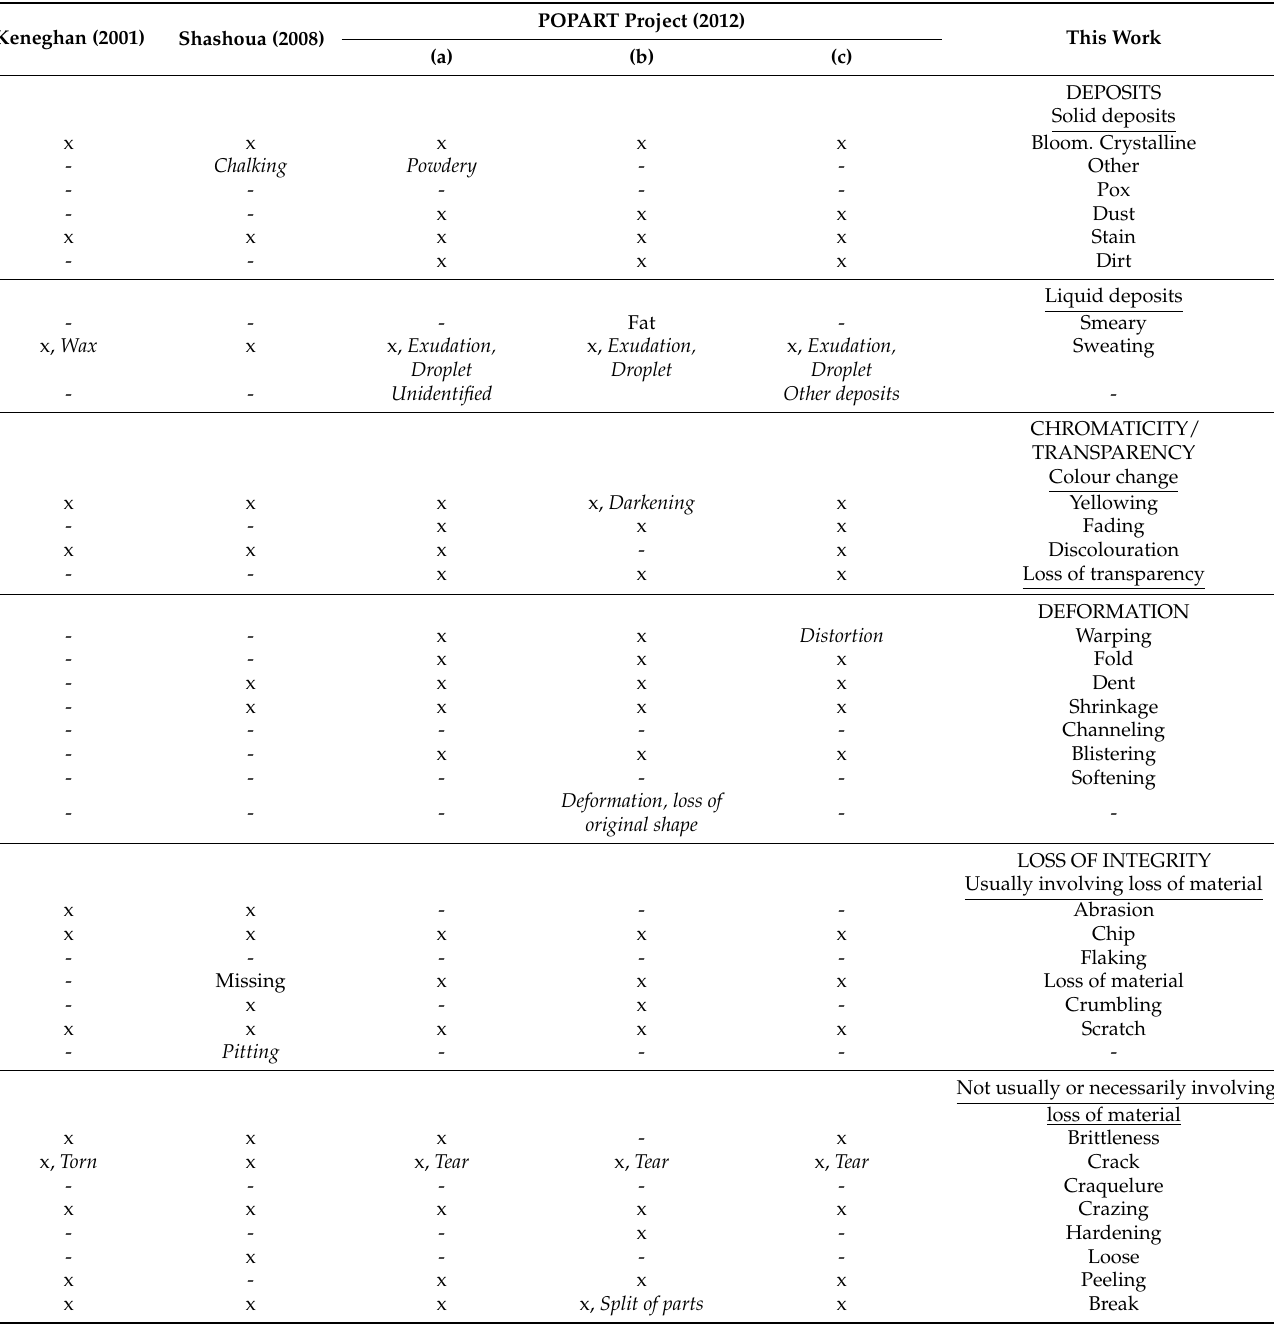
Table 1. Classification of damage phenomena according to Keneghan, Shashoua and as used in the surveys carried out during the POPART project, along with the terms proposed by this work. The terms in italics are terms considered to be related to the corresponding phenomenon used in this work (last column). The hyphen (-) indicates a term is not present in the work/column where it appears; an ‘x’ indicates that the term is present in the corresponding museum’s damage